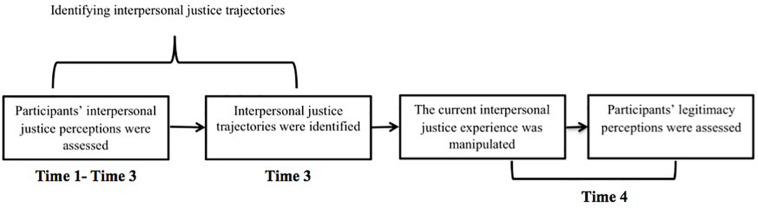
Summary of Study 2 Design.